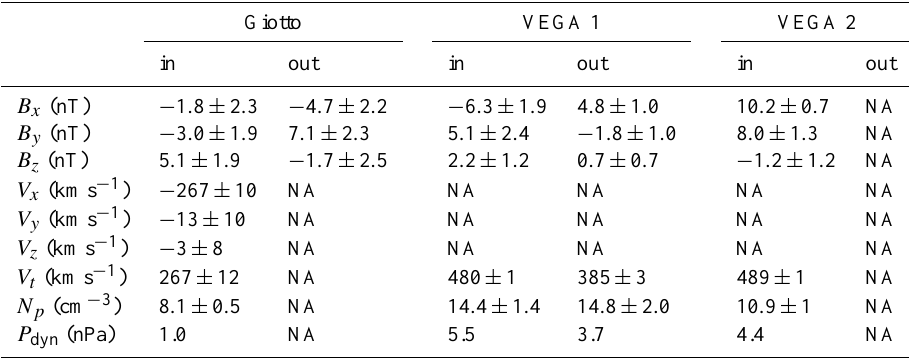
Table 1. 30min averages of the solar wind parameters before and after bow shock crossing.